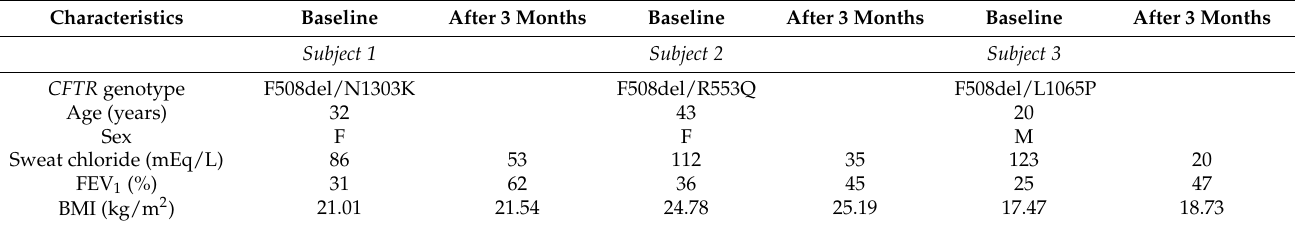
Table 1. Demographic information and outcome measures at baseline and 3 months after Elexacaftor- Tezacaftor-Ivacaftor